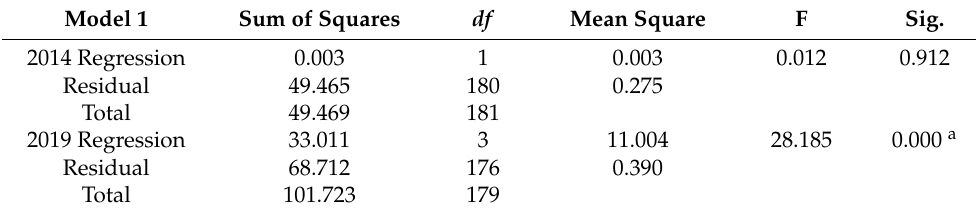
Table 3. Analysis of variance b in 2014 and 2019.